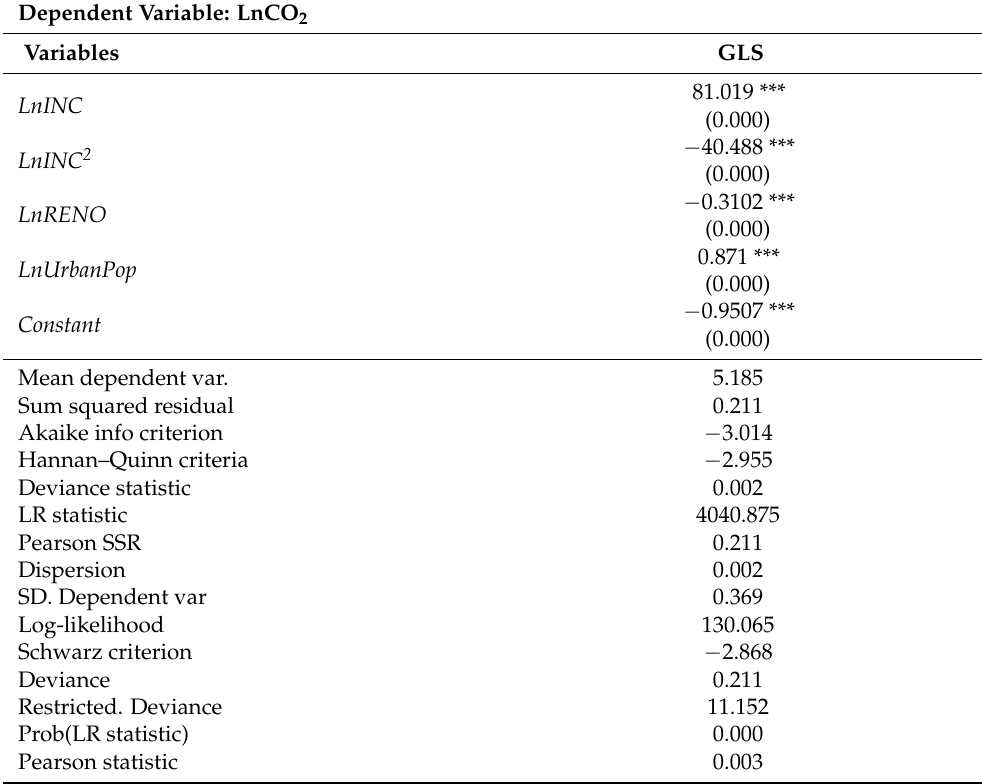
Table 7. Testing the Environmental Kuznets Curve with generalized least squares ( GLS )